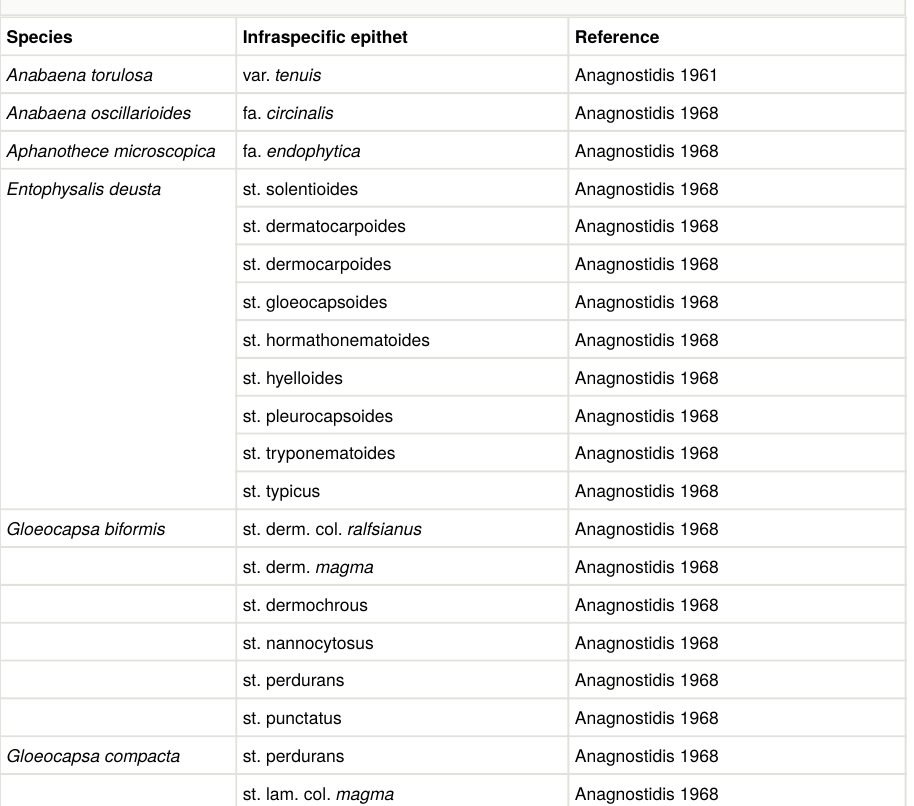
Table 1. List of infraspeci fi c cyanobacterial taxa known to occur in Greece. For each taxon the fi rst publication mentioning its occurrence in Greece is